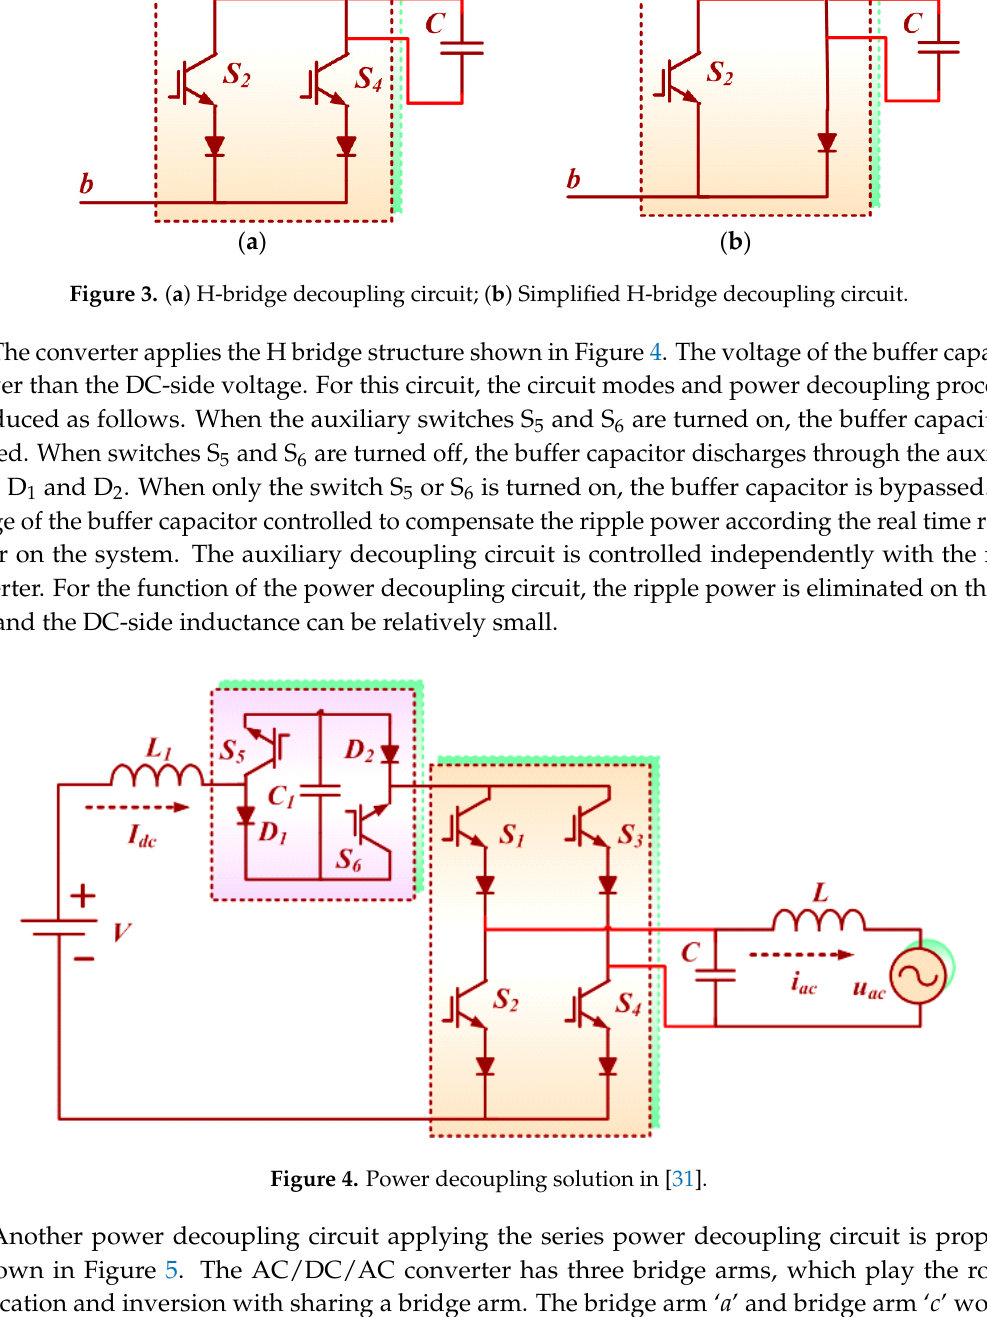
Figure 4. Power decoupling solution in [31].